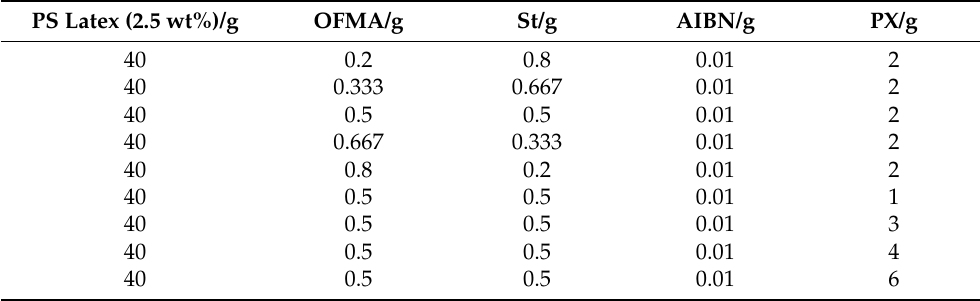
Table 1. Recipes for the preparation of PS/P(OFMA-S) composite